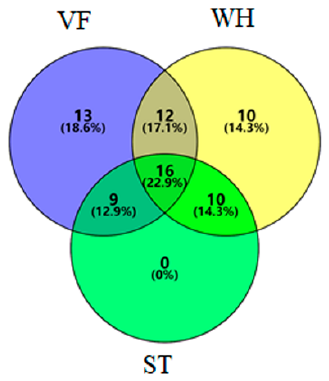
Figure 8. The distribution of the differentially abundant genera at the genus level in VF, WH, and ST.